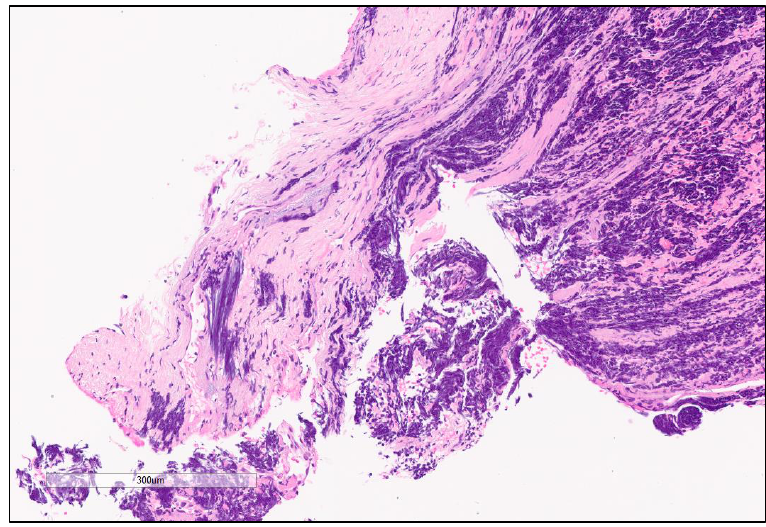
Figure 3. Chromatin smearing “crush artifact”. High magnification showing Small cell lung carci- noma (SCLC) with extensive chromatin smearing “crush artifact”.